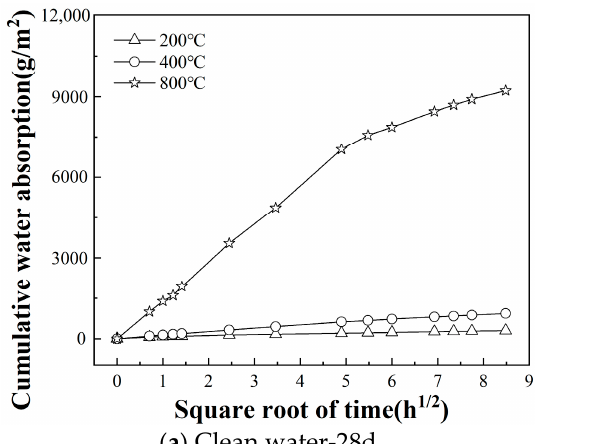
Figure 16. RCM results of UHPC after exposure to high temperatures and self-healing.